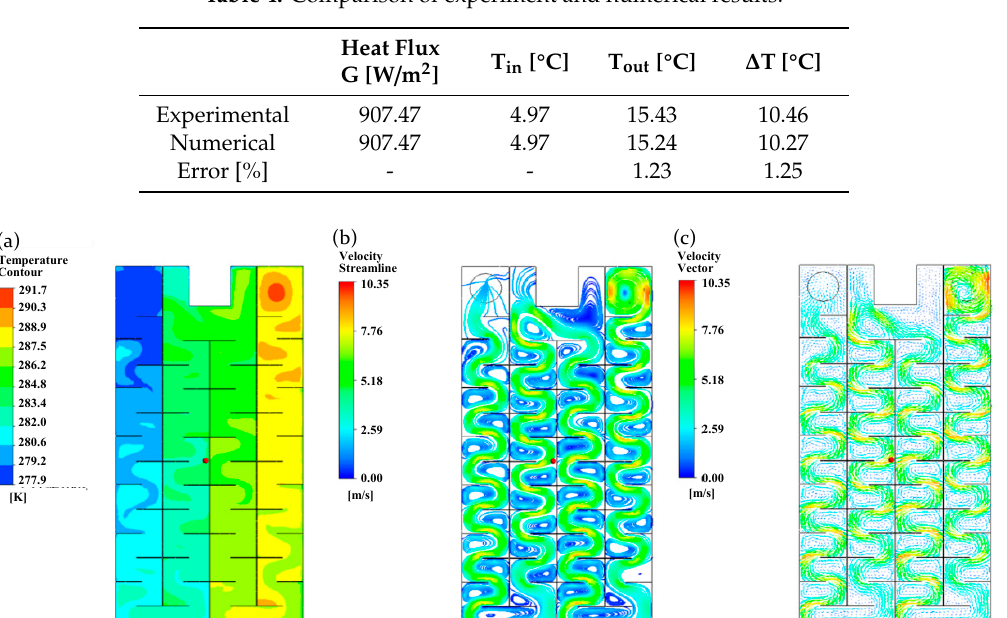
Table 4. Comparison of experiment and numerical results.